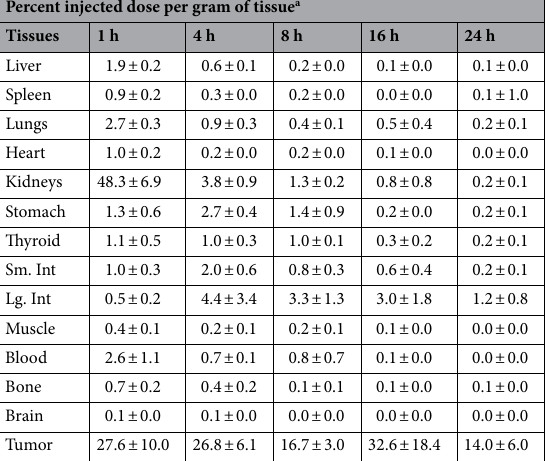
Table 2. Biodistribution of iso -[ 131 I]SGMIB-VHH_1028 in NOD SCID mice bearing BT474 xenografts. a Mean ± SD (n = 5).